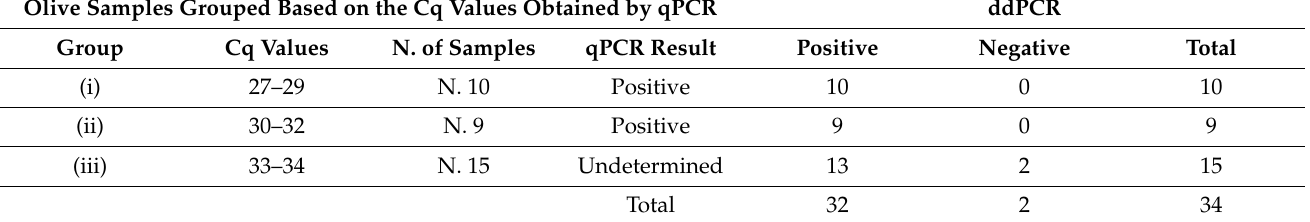
Table 5. Number of naturally infected olive samples assessed by qPCR assay as positive and undeter- mined (grouped in different ranges of the Cq values) compared with number of positive and negative samples detected by ddPCR assay.